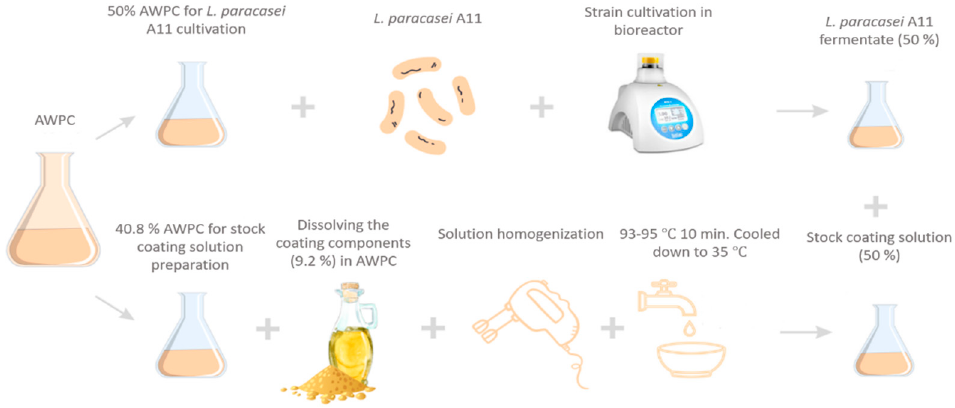
Figure 1. Scheme of the process followed for preparation of coatings.